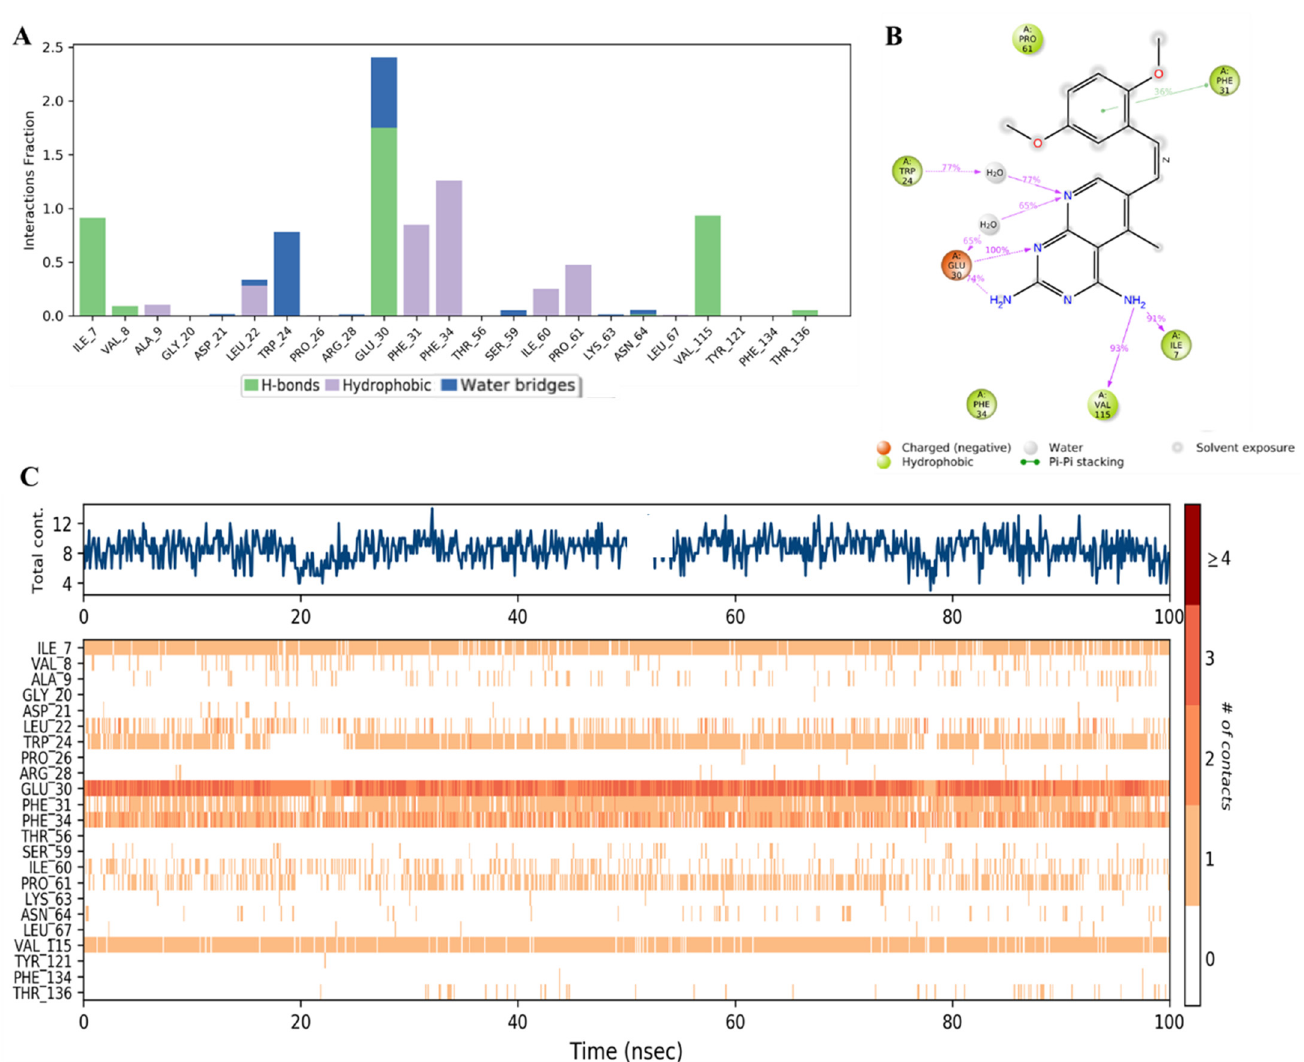
Figure 15. ( A ) Stacked bar graph of hDHFR (PDB: 1KMV) interactions with reference inhibitor SRI-9662 throughout the simulation. The values were normalized over the course of the trajectory. ( B ) A diagram illustrating the detailed connections of SRI-9662 with hDHFR. The coordination that appears at least 30% of the designated time period (0.00 to 100.00 nsec) will be presented. It is possible to observe more than 100% as some residues might be linked to the same ligand atom more than once; the pink colored arrows represent the hydrogen bond interaction while the % on the arrows represent the coordination % during the simulation time. ( C ) Timeline of hDHFR- SRI-9662 interactions presented in ( A ). The top panel presents the total number of specific interactions the protein made with the ligand over the course of the trajectory. The bottom panel presents the residues interacting with the ligand in each trajectory frame. The dark orange color indicates more than one specific interaction is made between some residues and the ligand. As the orange color becomes lighter, the number of contacts between the residue and ligand decreases. The white color indicates no interaction is formed.